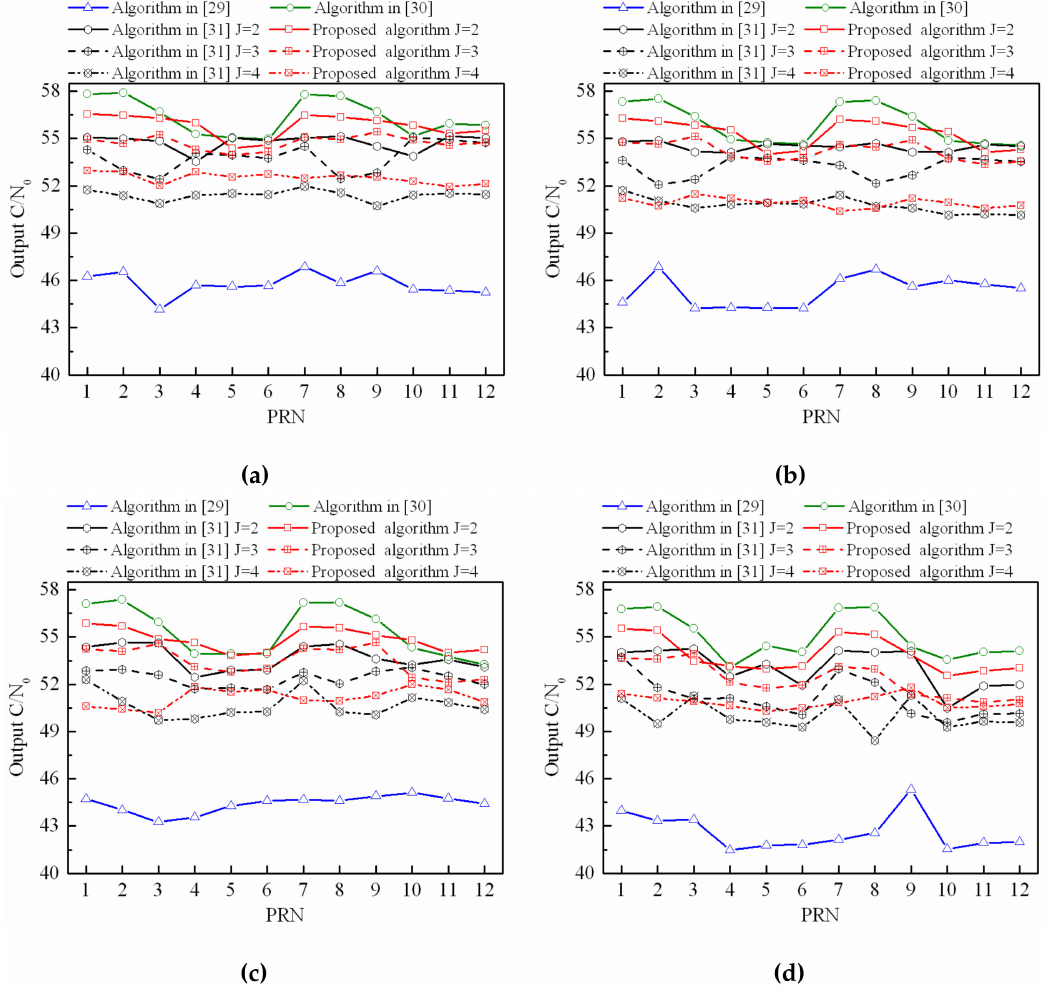
Figure 10. Output C/N 0 performance comparison between the proposed STPAP algorithm and the STPAP algorithms based on the criterions in [29–31] when there are interferences with different polarization modes: ( a ) one interference; ( b ) two interferences; ( c ) three interferences; ( d ) four